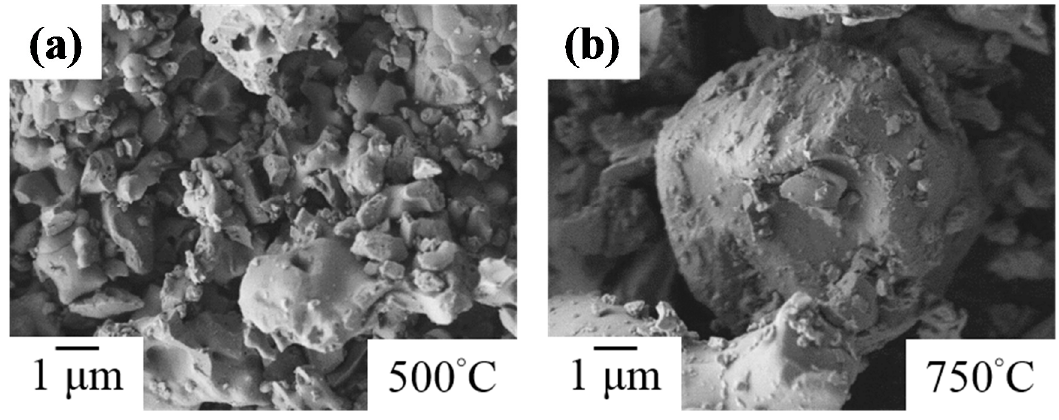
Figure 3. SEM images of sol-gel Bi 2 O 3 powders after heat-treatment at: ( a ) 500 ◦ C; and ( b ) 750 ◦ C. TEM observation was further used to investigate the heat effect on the microstructure of the sol-